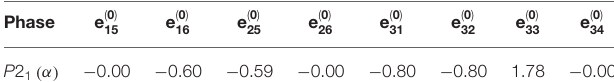
TABLE 4 | The piezoelectric tensor components e (0) ij of aluminum nitride (in C/m 2